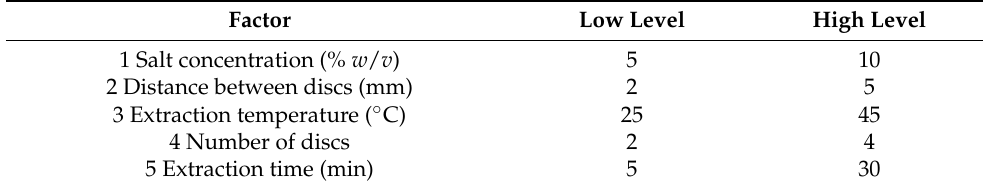
Table 1. Application of DOE 2 5 to optimize HS-SPME extraction. Factor Low